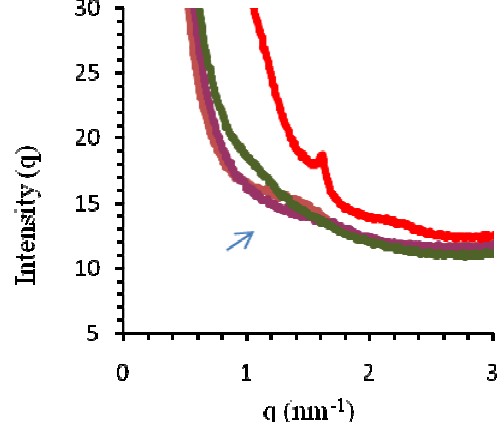
Fig. 7. SAXS: (brown) 14 up, (purple) 28 film powdered, (green) 28 film and (red) 14 down.